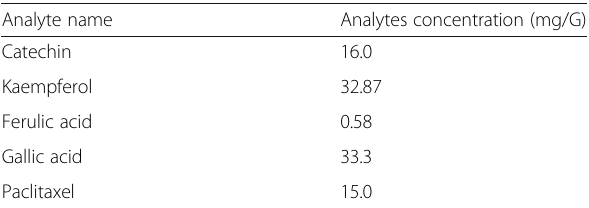
Table 5 Content (mg/g) of five bioactive compounds detected in B.